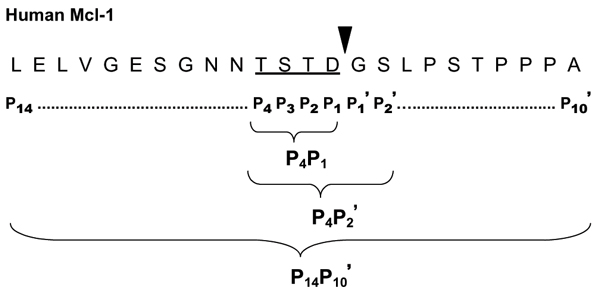
Different subsequence segments for SVM training and testing. For human Mcl-1 [Swiss-Prot:Q07820], a sequence window of 24 amino acids in length centred on the tetrapeptide cleavage site, TSTD (underlined) is shown. Amino acids to the left of the scissile bond (shown by the inverted triangle) are labelled from P1 (D) to P14 (L). Amino acids to the right of the scissile bond are labelled from P1' (G) to P10' (A). Curly brackets indicate the subsequence segments extracted for SVM implementation. The sequences spanning P4 to P1 (TSTD), P4 to P2' (TSTDGS) and P14 to P10' (LELVGEGSNNTSTDGSLPSTPPPA) are labelled as P4P1, P4P2' and P14P10' respectively.